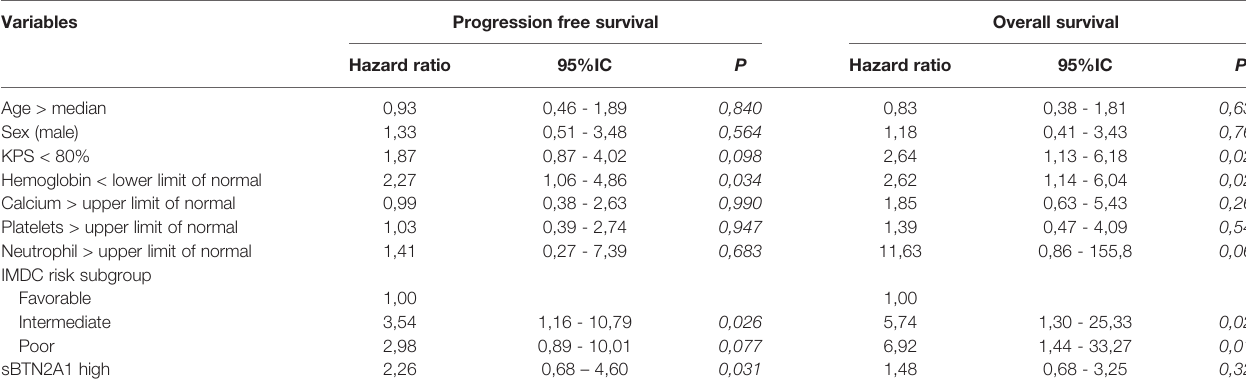
TABLE 2 | Univariate hazard ratio for PFS and OS.